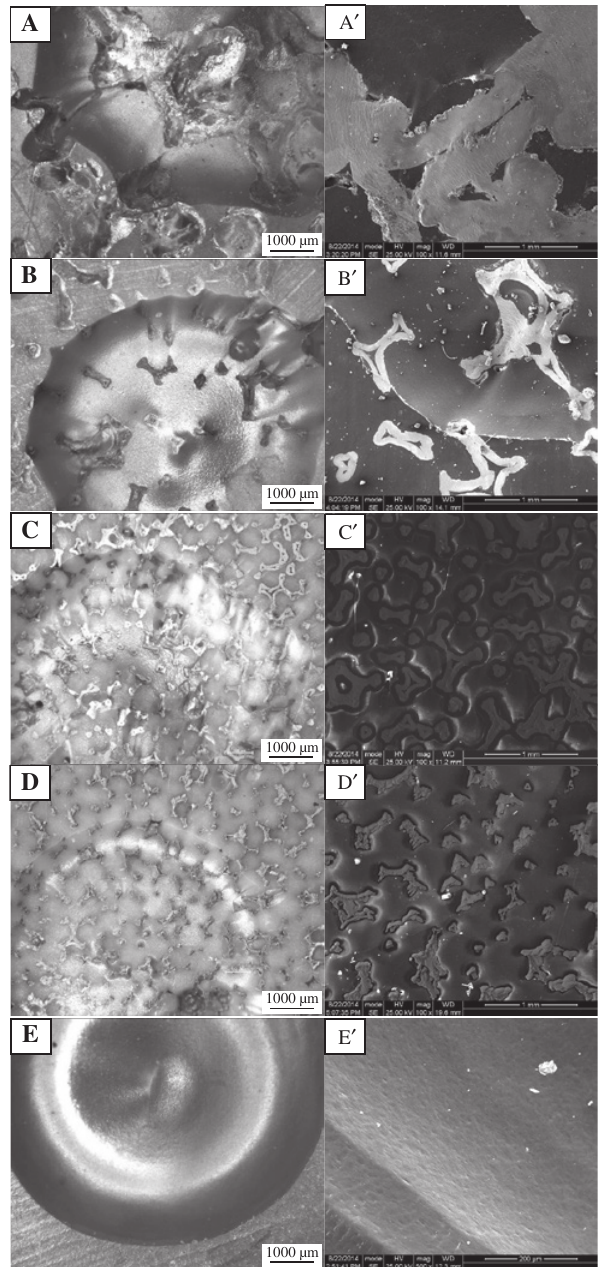
Figure 5: Morphologies of PEEK/Ni foam composites and pure PEEK after erosion-corrosion test with an impact angle of 90 ° observed using optical microscopy (A–E) and SEM (A ′ –E ′ ): (A and A ′ ) PEEK/ Ni25, (B and B ′ ) PEEK/Ni50, (C and C ′ ) PEEK/Ni100-1, (D and D ′ ) PEEK/Ni100-2, and (E and E ′ ) PEEK.